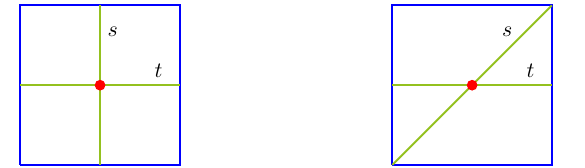
Figure 7 . Schematic pictures of the spaces C 6 / Z 2 × Z 2 and C 6 /G (3 , 1 , 2) . The green lines represent the fixed loci of the generators s, t that they are labelled by. The red dot is the intersection of the two fixed